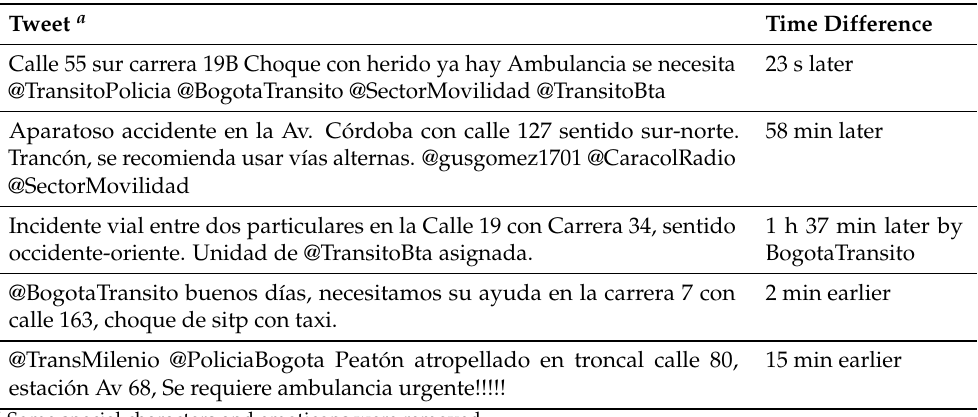
Table 17. Tweets map-matched by accident official data.